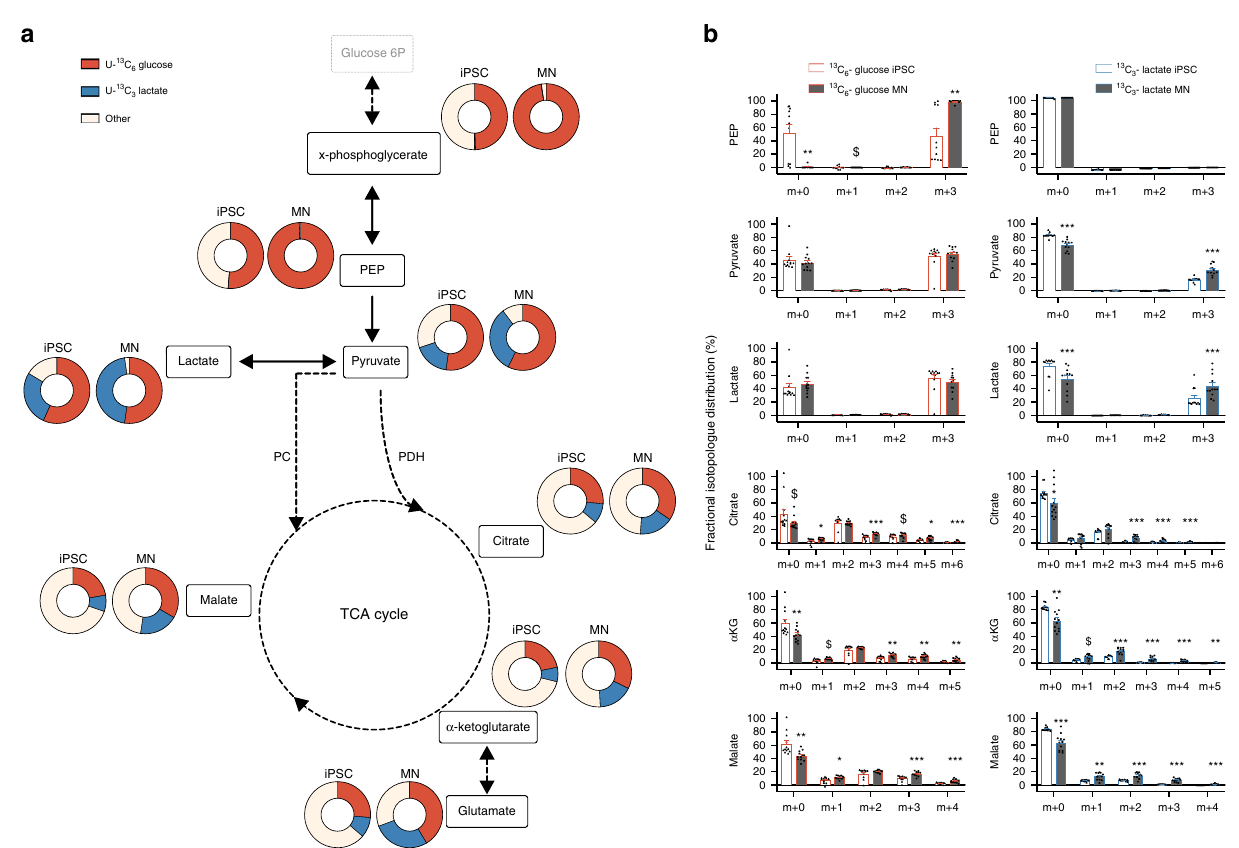
Fig. 2 Metabolic fate of lactate and glucose in human iPSCs and MNs. a Fractional contribution of uniformly labelled 13 C glucose (red) and uniformly labelled 13 C lactate (blue) to metabolites from glycolysis and TCA cycle in human iPSCs and motor neurons. b Relative abundance of each isotopologue for speci fi c metabolites. $ p < 0.10, * p < 0.05, ** p < 0.01, *** p < 0.0001 versus iPSC. Statistical analyses were performed by two-tailed t tests to compare iPSCs and motor neurons. The data represent mean ± s.e.m. from four control cell lines from three independent experiments, with individual data points shown. Thin black arrows represent direct metabolic pathway connections; dashed arrows indicate that additional intermediate reactions are involved in the metabolic pathway. Source data are provided as a source data fi le. 13 C 6 -glucose uniformly labelled glucose, 13 C 3 -lactate uniformly labelled lactate, PEP phosphoenolpyruvate, PC pyruvate carboxylase, PDH pyruvate dehydrogenase, α KG alpha-ketoglutarate, TCA tricarboxylic